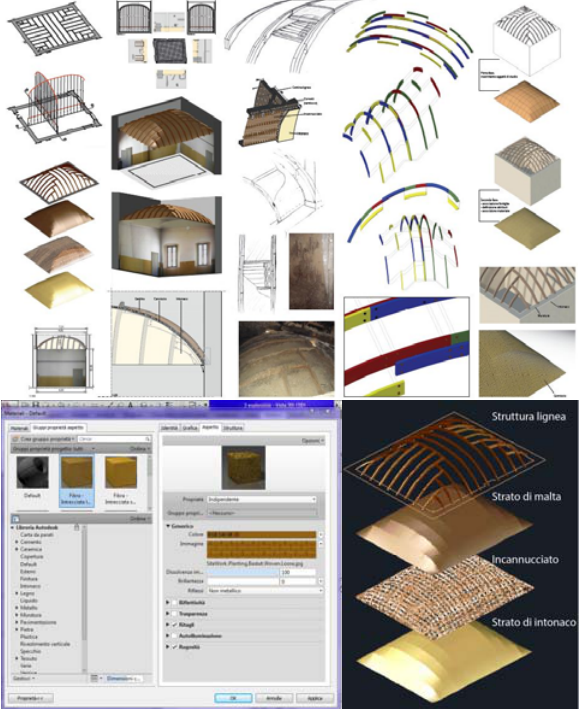
Figure 4. Church of Saint Maria in Scaria d’Intelvi (Como - Italy). (Up left) Laser scanner point clouds, transversal section and plan of the church with indication of the different constructive phases derived from the cross-relation of historical data and surveying data interpretation. The 3D model of the church (down) is made with BIM software (©Autodesk Revit).